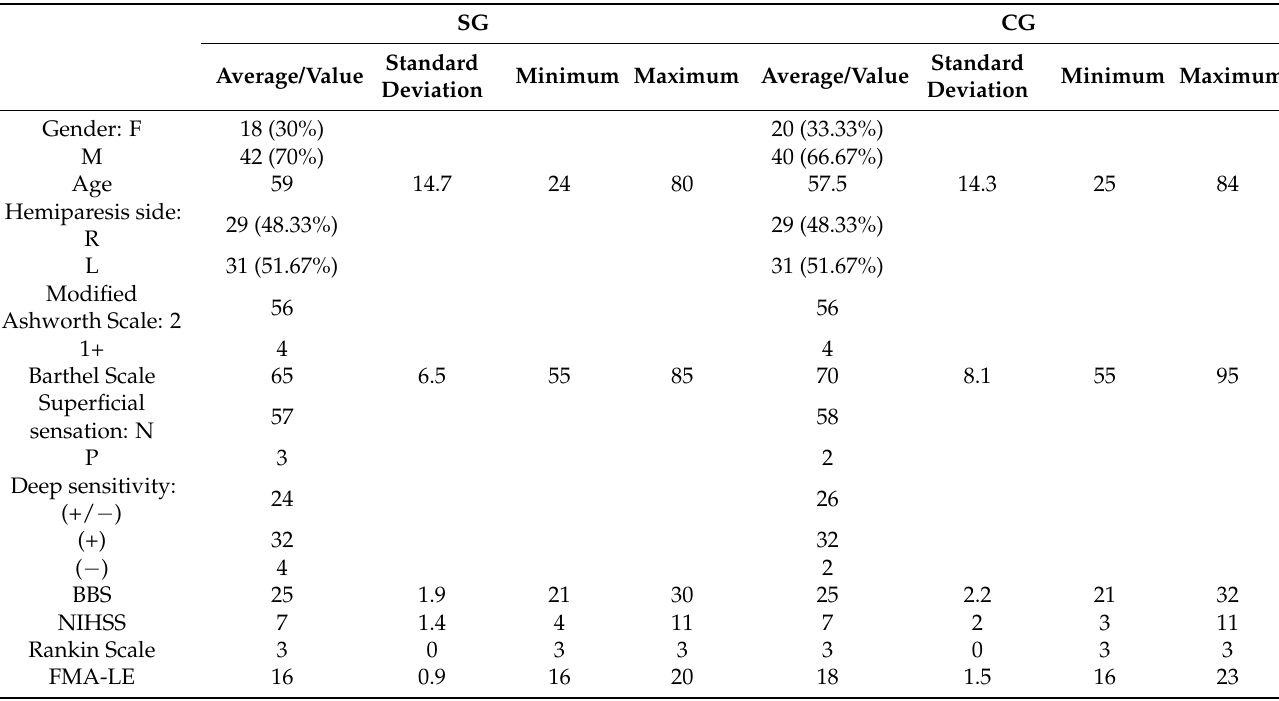
Table 3. Demographic and functional characteristics of SG and